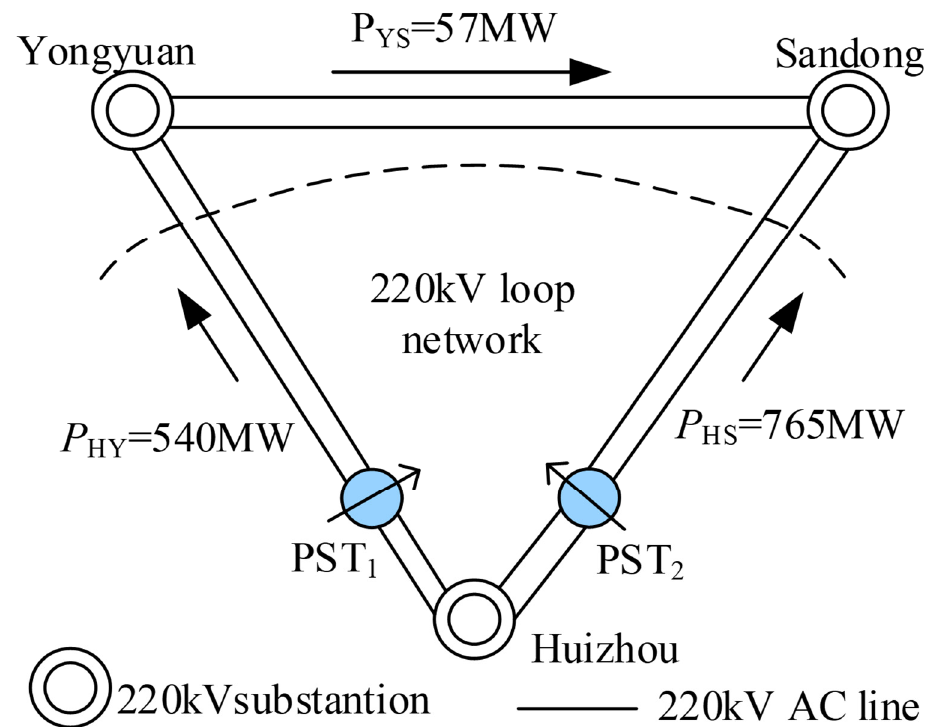
Figure 10. 220 kV transmission lines and PST location .